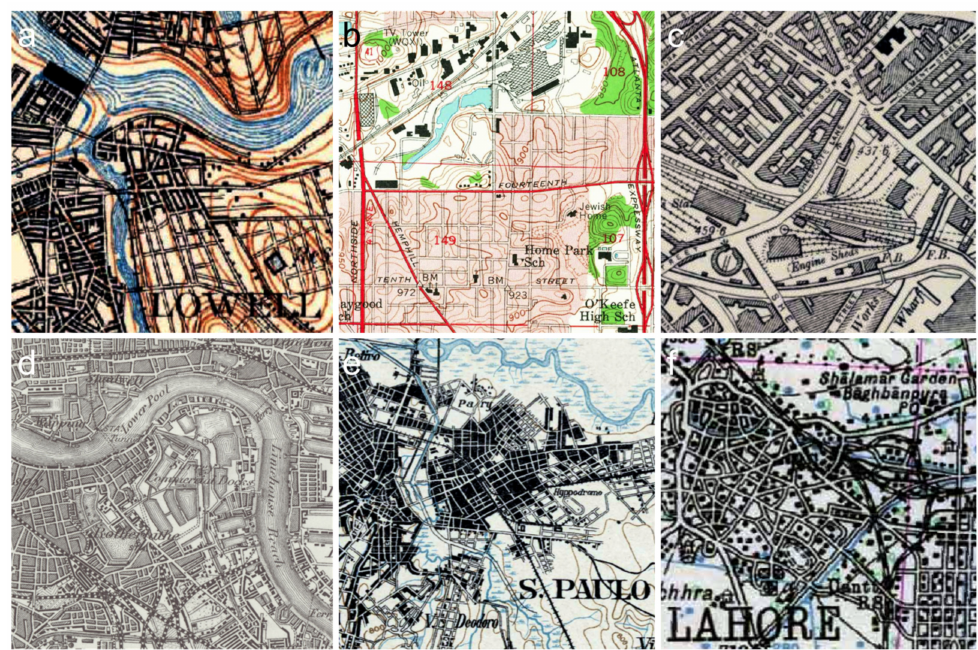
Figure 3. Cartographic styles used to depict urban built-up areas in the historical maps used in this study: ( a ) Boston (~1900), ( b ) Atlanta (~1960), ( c ) Birmingham (~1900), ( d ) London (1896), ( e ) Sao Paulo (1906), and ( f ) Lahore (1943).